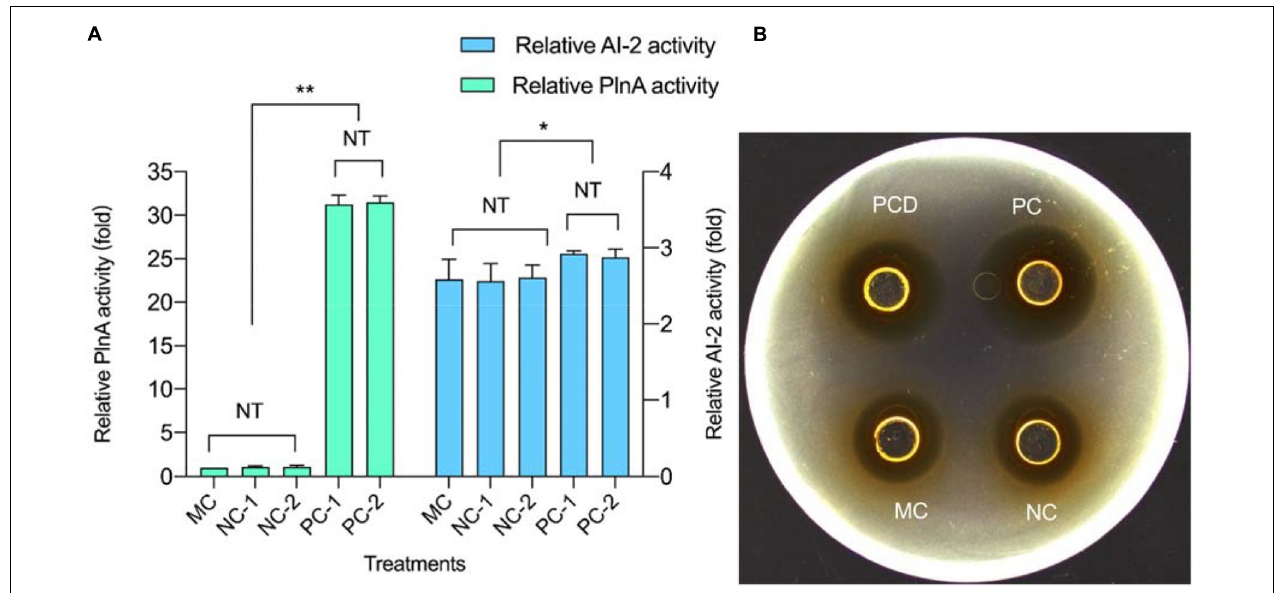
FIGURE 3 | Quorum-sensing (QS) signal molecule secretion and plantaricin production at 24 h in co-culture. (A) QS signal molecules. (B) Plantaricin production. PC means positive bacteriocin-inducing co-culture of L. plantarum RX-8 and B. subtilis BS-15 (10 6 :10 6 CFU/ml) at 37 ◦ C for 24 h, PCD means PC with 200 mM D-ribose, and NC means negative bacteriocin-inducing co-culture of L. plantarum RX-8 and B. subtilis BS-15 (10 6 :10 4 CFU/ml) at 37 ◦ C for 24 h. MC means monoculture of L. plantarum RX-8 (10 6 CFU/ml) at 37 ◦ C for 24 h. “1” represents CFS from the upper well, and “2” represents CFS from the bottom well. NT indicates that there were no significant differences in the results between the control; * p < 0.05 and ** p < 0.01. The relative AI-2 activity (fold) is defined as (the RLU of CFS)/(the RLU of blank control). The relative PlnA activity (fold) is defined as (the bacteriocin activity of co-culture)/(the bacteriocin activity of monoculture).